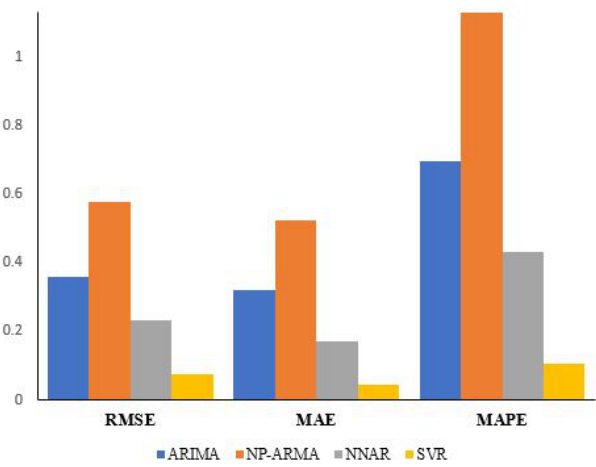
Figure 12. Forecasts comparsion for the COVID-19 dataset taken from Mexico.